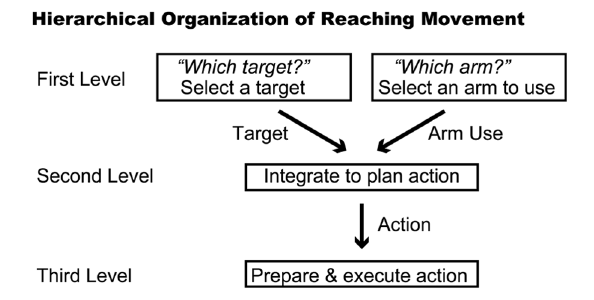
FIGURE 3 | Hierarchical organization of reaching movement. Three levels of information processing are summarized schematically.The first level represents the components of the reaching movement, such as arm use and target location.The second level integrates these components to plan the reaching movement.The third level prepares and executes the planned movement.